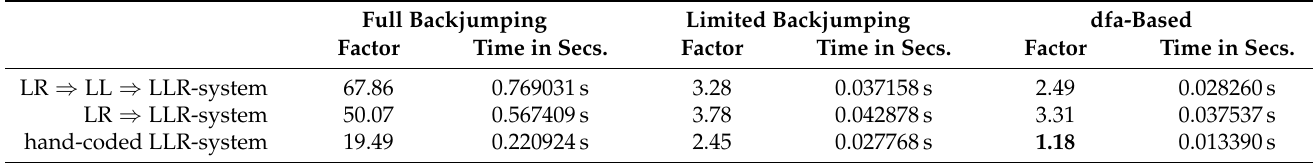
Table 2. The running times of parsing an arithmetic expression consisting of a million symbols using the full backjumping, limited backjumping and DFA-based algorithm for the different LLR-systems derived from the context-free grammar in Example